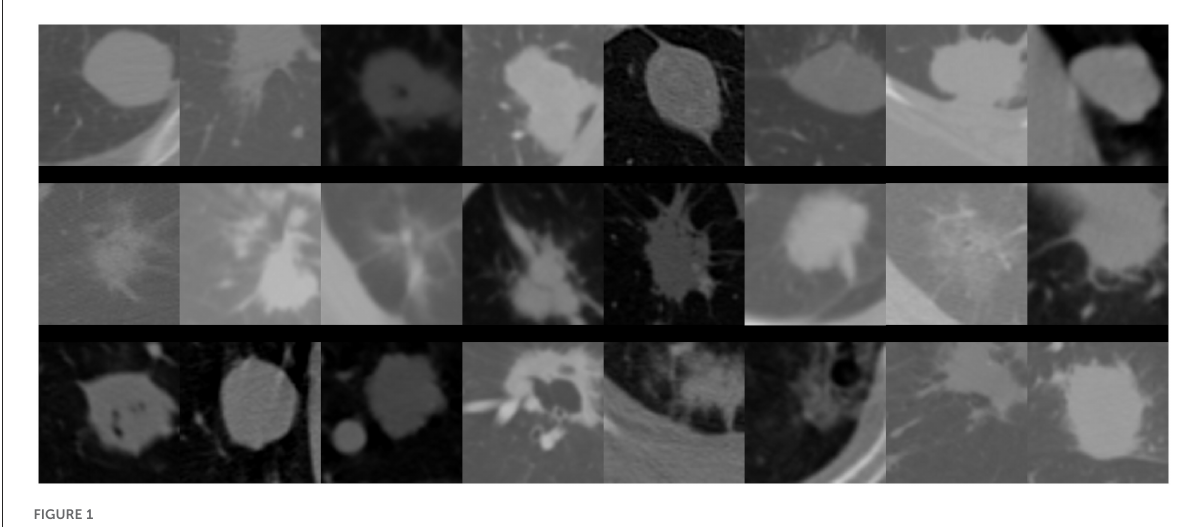
FIGURE1 Schematic diagram of lung